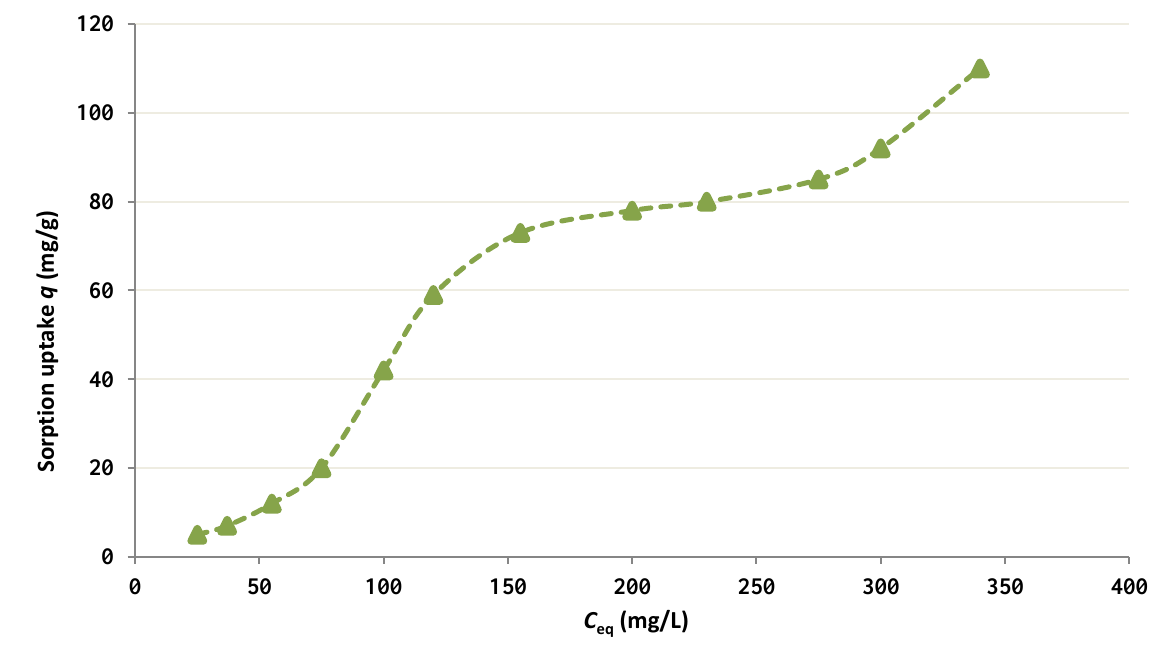
Figure 3. Adsorption isotherm for Co at higher equilibrium concentrations.